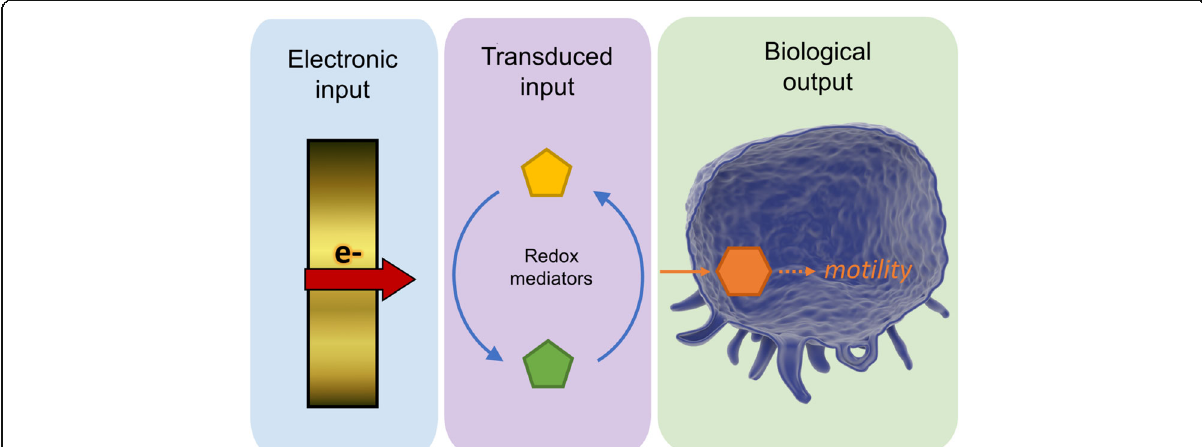
Fig. 4 Transduction of signals on a bioelectrochemical system. An electronic input in the form of potential modulates the redox state of naturally occurring electrochemical mediators, from an inactive state to an active state or vice versa , and are communicated to a cellular system triggering biological response (Tschirhart et al.